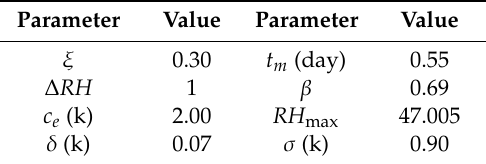
Table 2. Maintenance parameter values.